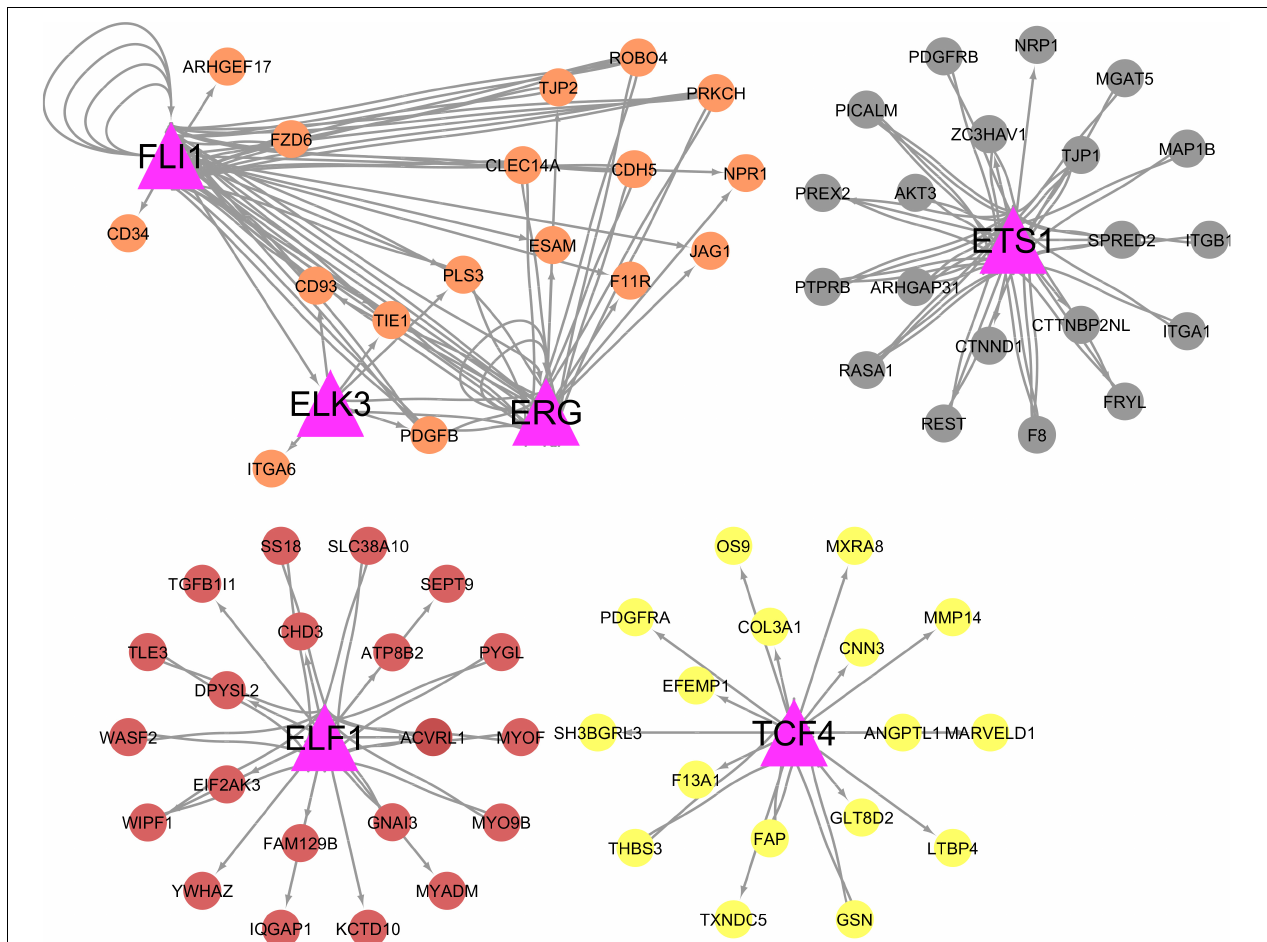
FIGURE 7 | Integration of the transcription factors (hub-TFs) with their targets. Pink triangles represent hub-TF genes. The colors of the nodes are based on the module for which the hub-TF belongs.